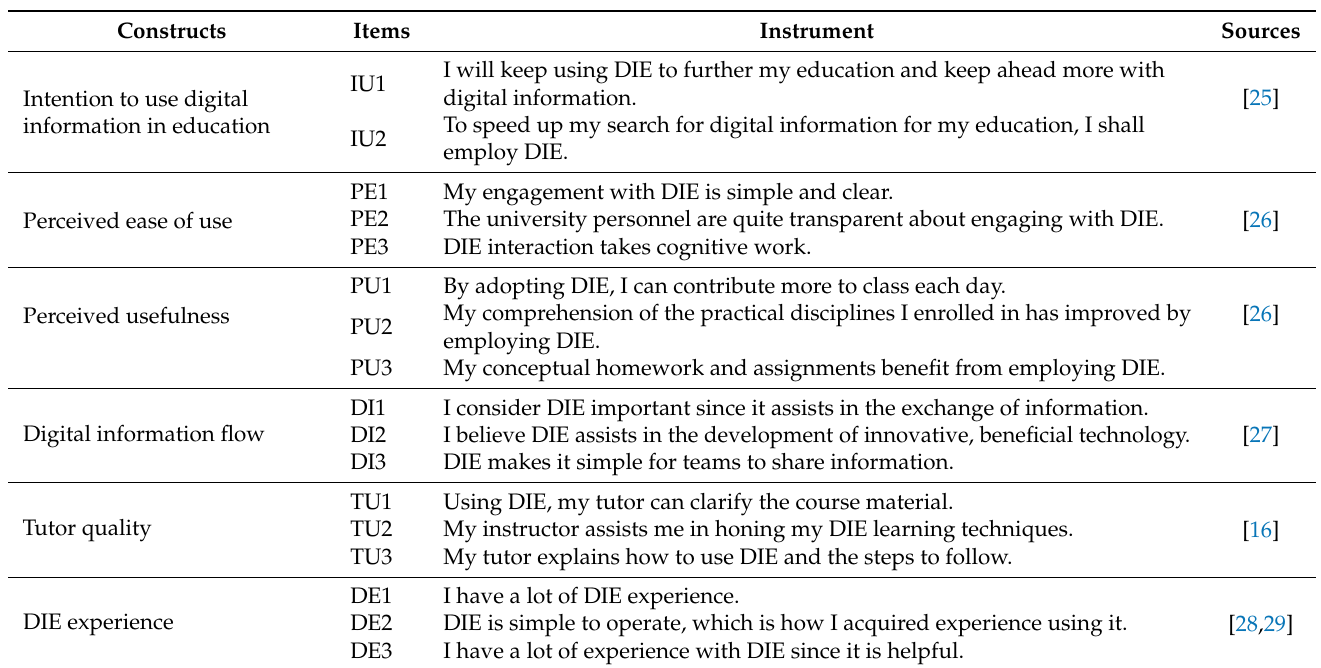
Table 2. Measurement Items.